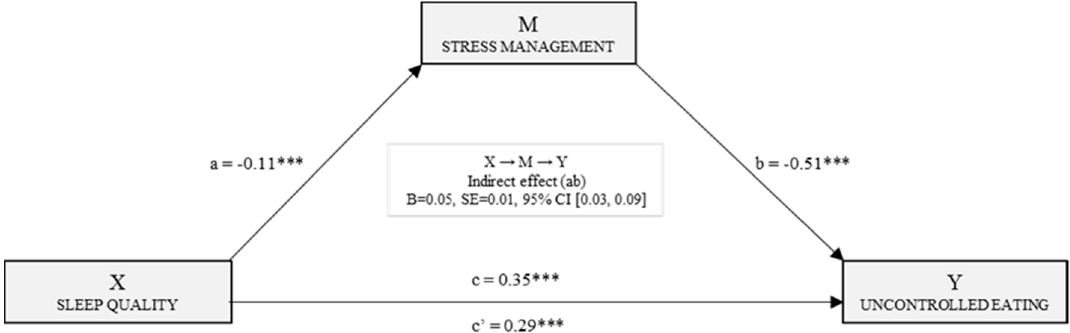
Figure 3. Simple mediation model of stress management in the relationship between sleep quality and uncontrolled eating. Note. *** p < 0.001.